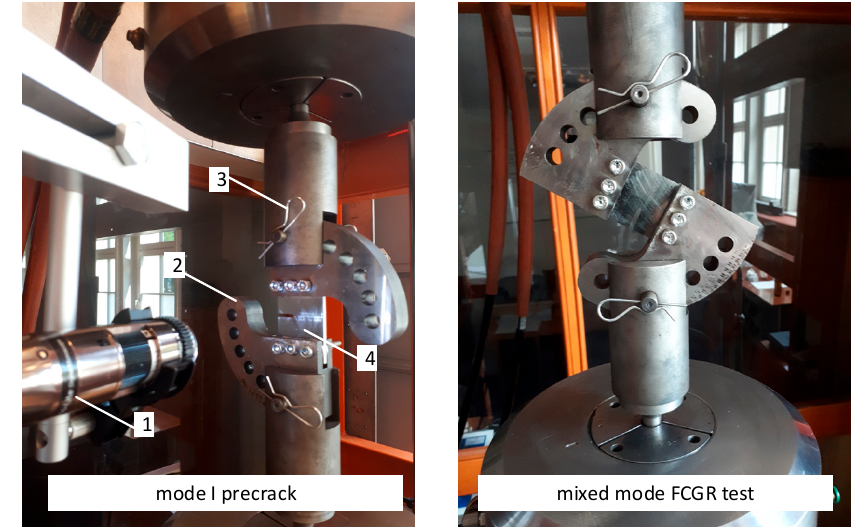
Figure 15. Mixed mode fatigue crack growth test (1—DinoLite digital microscope, 2—Richard’s fixture, 3—upper clevis, 4—specimen).